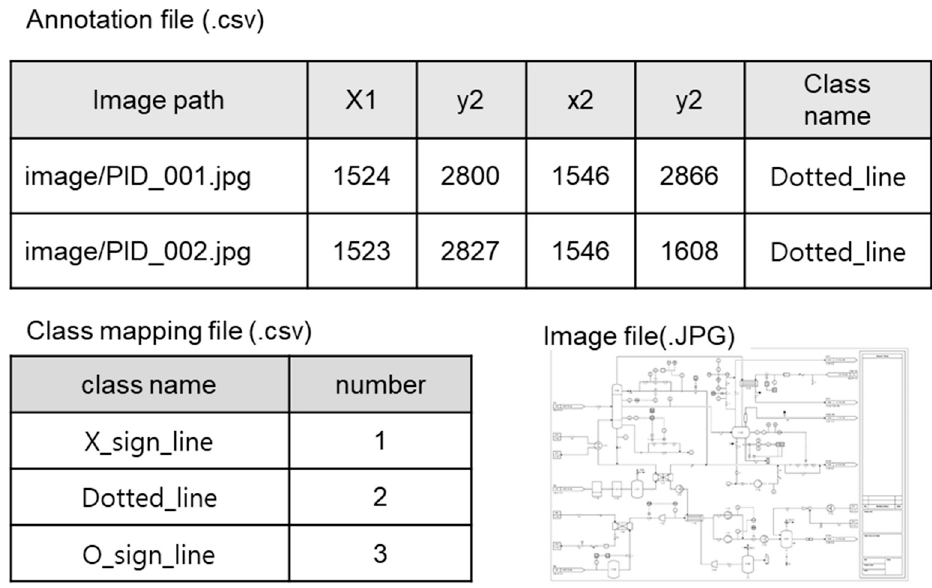
Figure 4. Composition of training data.